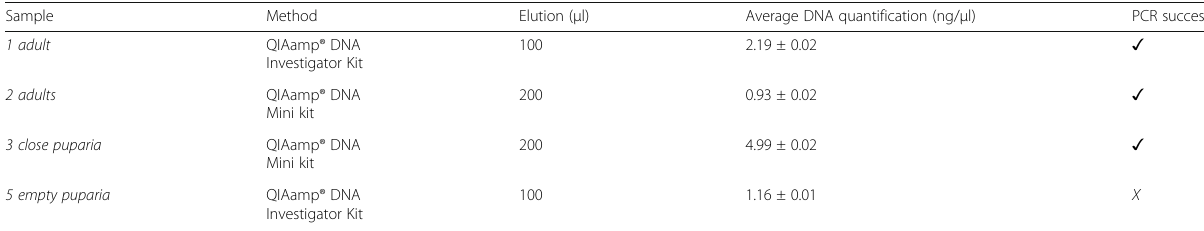
Standard deviation is reported. ✓ positive PCR, X negative PCR